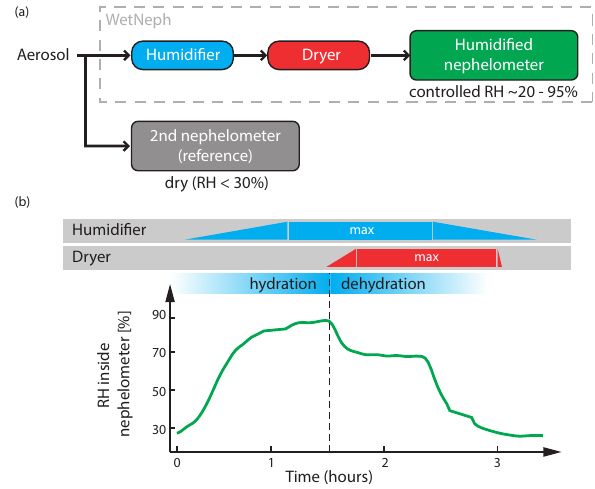
Fig. 1. (a) Block diagram of the WetNeph setup consisting of a humidifier, a dryer, and a modified nephelometer. A second neph- elometer was always operated in parallel as a reference instrument. (b) Schematic time profile of the relative humidity inside the humid- ified nephelometer. The performance of the humidifier and dryer is shown schematically above the diagram. More technical details can be found in Fierz-Schmidhauser et al.